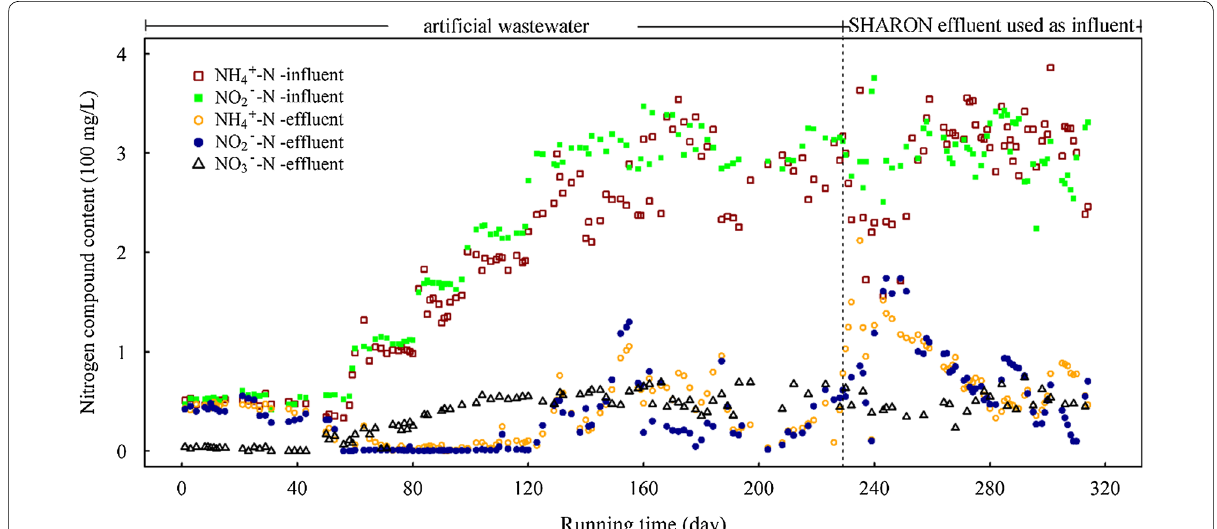
Fig. 1 Performance of ANAMMOX reactor during entire running time. Dotted line: day 229, when SHARON effluent was introduced as ANAMMOX